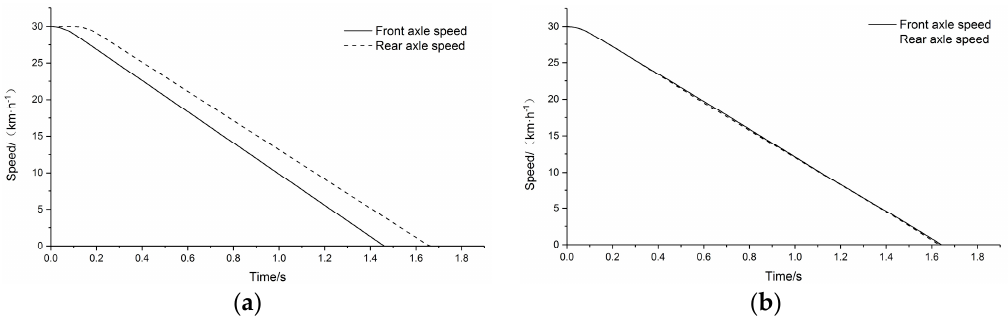
Figure 7. ( a ) Pure mechanical inertia; ( b ) electromechanical inertia compensation.